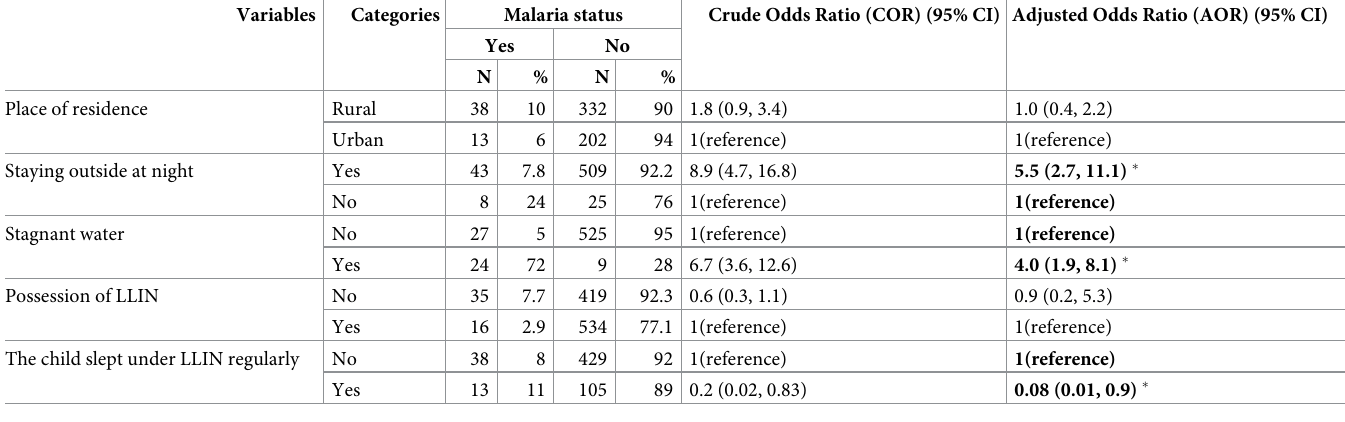
Table 4. Factors associated with malaria infection in under-five children, Wogera district, northwest Ethiopia,